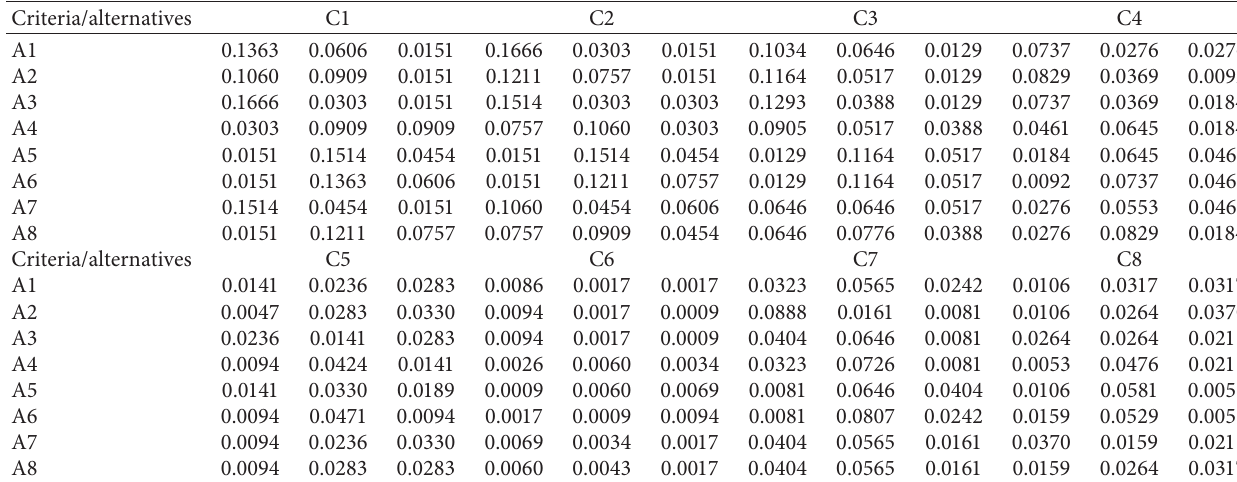
Table 11: Weighted normalized PF-DMT